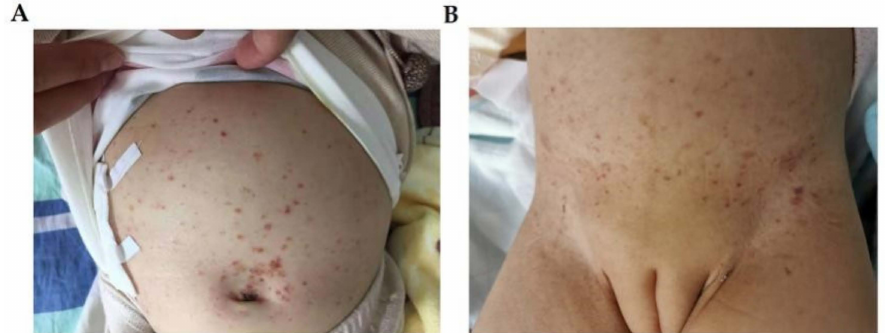
Figure 3. The skin manifestations of patient 3 ( A ) and patient 4 ( B ). ( A ) brownish-red maculopapules and crusts on her bulging abdomen. ( B ) The skin manifestations of patient 4: eczema-like dispersed erythema, papules and pigmentation can be seen on the